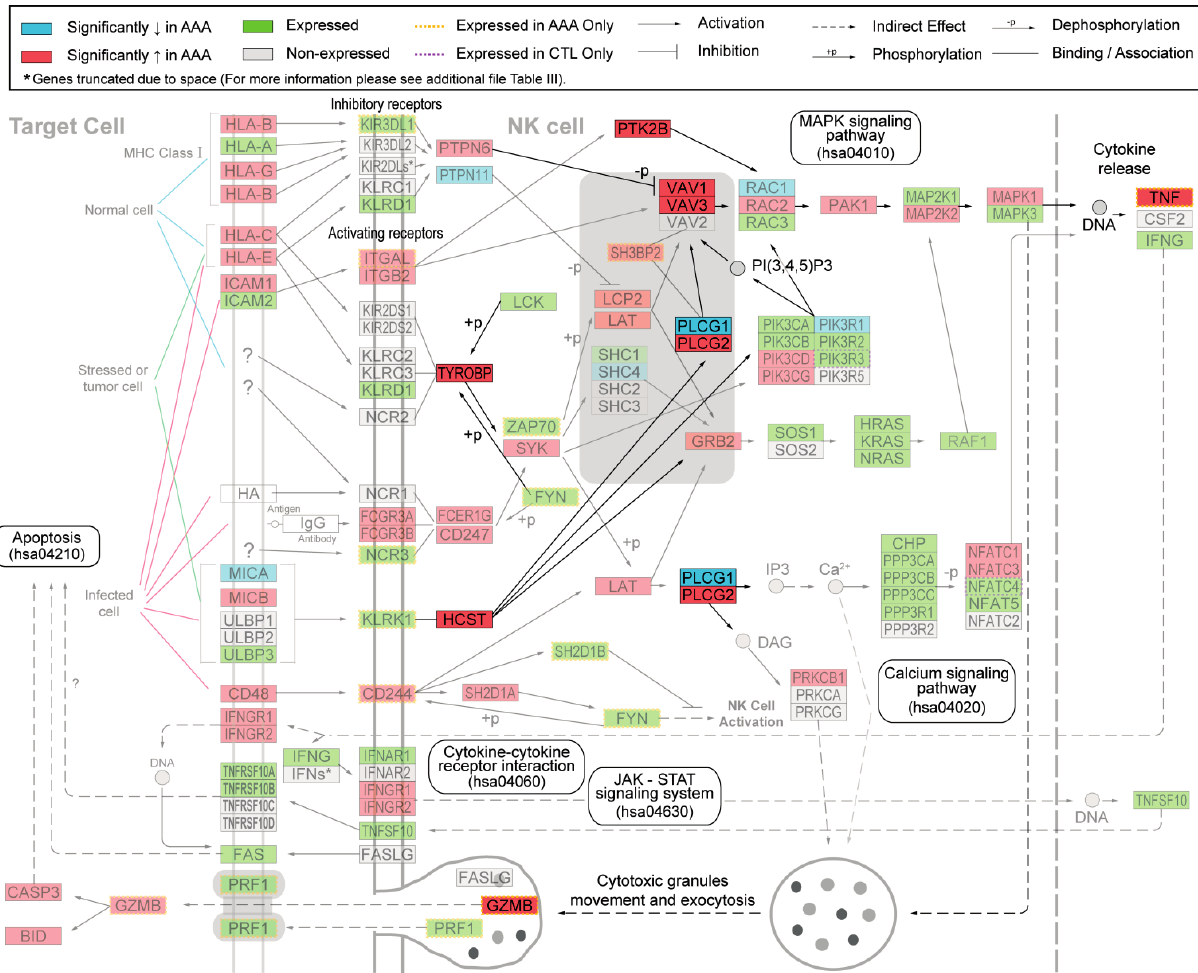
Figure 1. Modified “Natural Killer Cell Mediated Cytotoxicity” (hsa04650) pathway from Kyoto Encyclopedia of Genes and Genomes (KEGG). Protein symbols were replaced by gene symbols. Proteins investigated in the current study using immunohistochemical analysis of human aortic tissue samples from abdominal aortic aneurysm (AAA) and non-AAA samples are shown in bright colors. See key for explanation of colors and symbols. The figure is modified from our previous study